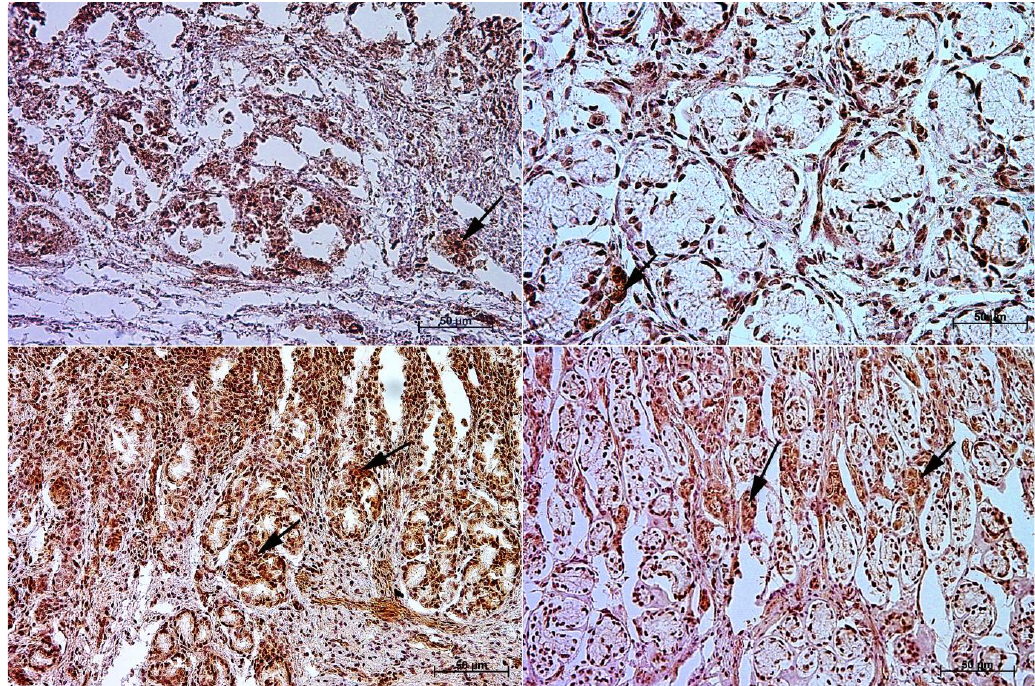
Figure 6. Immunoreactivity of anti-cholecystokinin antibody in the pyloric mucosa of the stomach, 40×. ( A ) the first age group, ( B ) the second age group, ( C ) the third age group, ( D ) adult reference group. The arrow indicates positive immunohistochemical reaction. Table 4. Immunoreactivity of anti-cholecystokinin antibody. Age [Months] The first age group (4 – 5 Month of gestation) IRS mean/SD Description